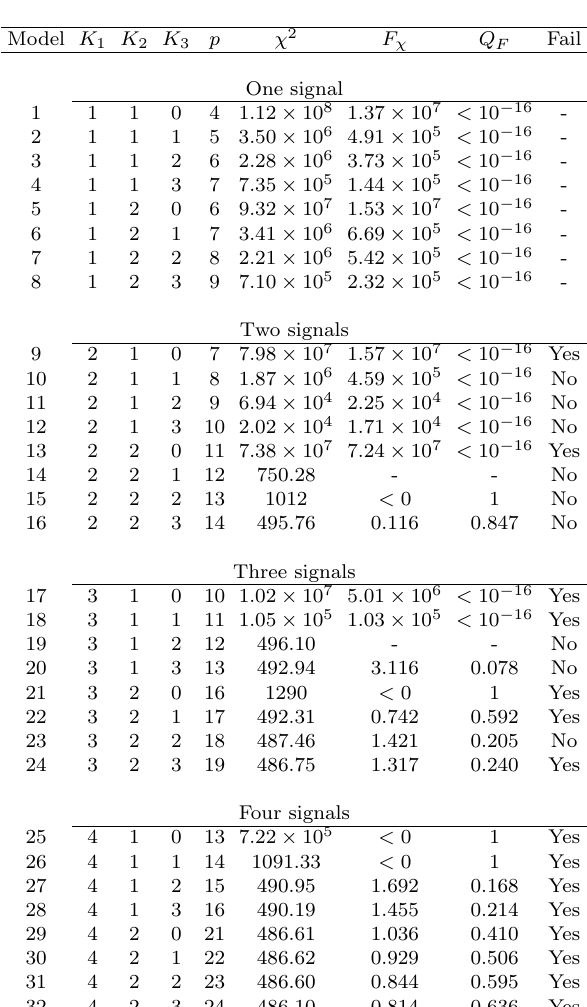
TABLE 4 Comparing 32 nested models. Parameters are K (Eq. 1), p (Eq. 6), χ 2 (Eq. 8), F (Eq. 12) and Q χ Critical levels Q are computed for Model 19. Last F column gives failed models (Fail=Yes or